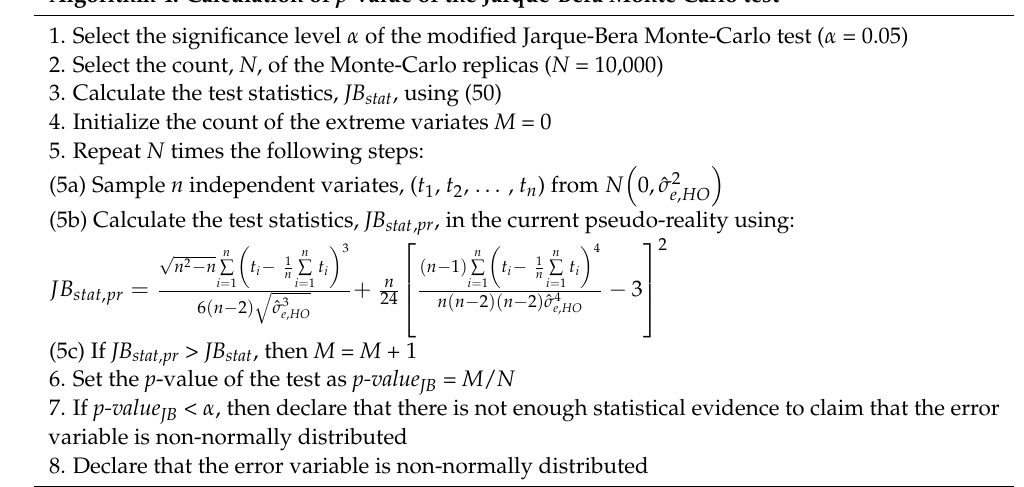
Algorithm 4: Calculation of p -value of the Jarque-Bera Monte Carlo